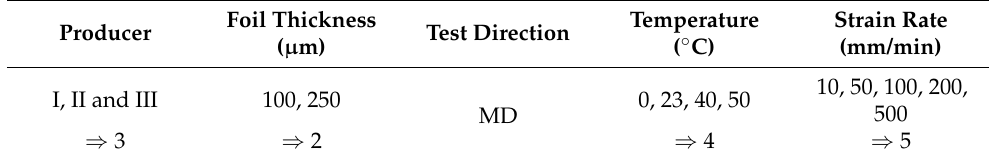
Table 2. Test matrix for the determination of the influence of different test temperatures and strain rates on ETFE